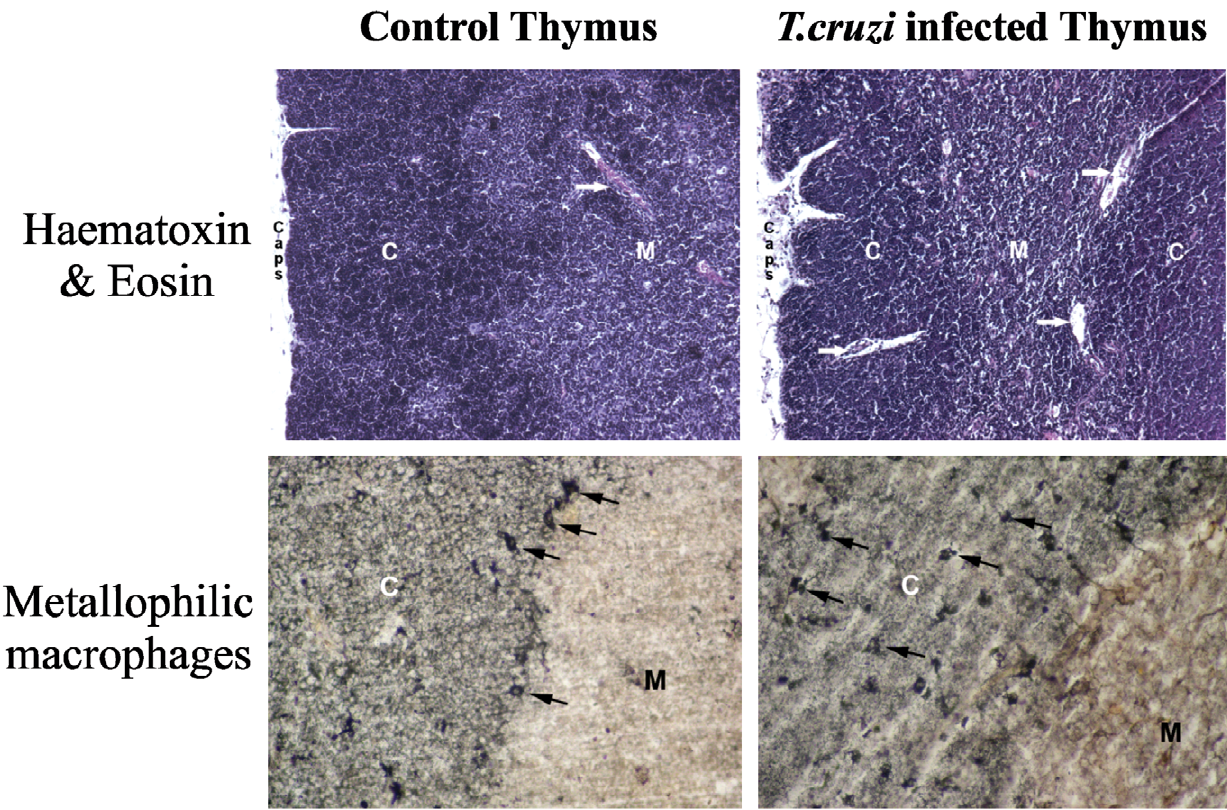
Figure 1. Thymic atrophy in BALB/c acutely infected with T.cruzi . The histological profiles show the (upper left) normal thymic architecture (C, cortex; M, medulla) and (upper right) marked cortical and medullary atrophy in the thymus of an acutely-infected mouse. (lower left) The numerous metallophilic macrophages are present in the cortico-medullary zone (arrows) of normal thymus. However, following T. cruzi acute infection (lower right) the number and distribution of metallophilic macrophages are changed with the cells dispersed throughout not only the cortico-medullar area but also the cortical region. Infected mice were evaluated herein at day 15 post-infection. These data are representative of two independent experiments using four mice per group.